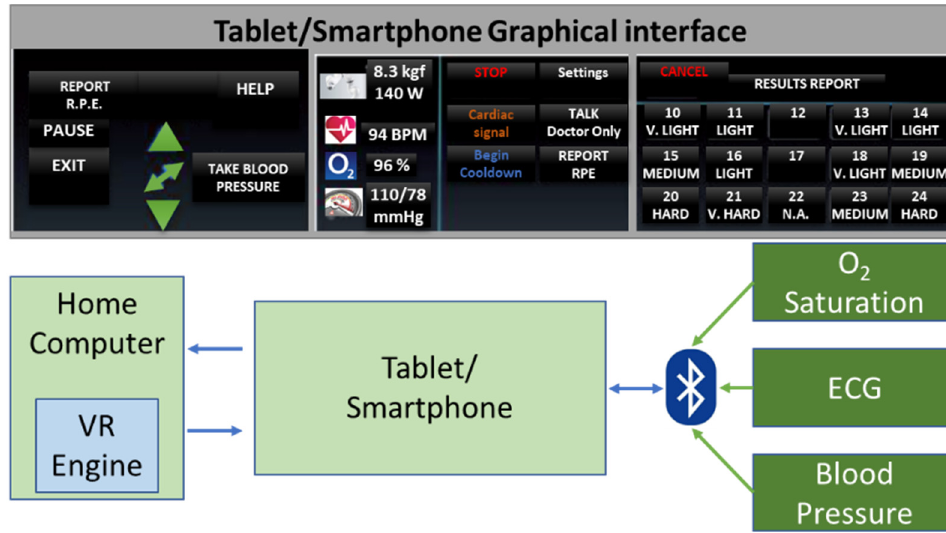
Figure 6. Tablet/smartphone interface and data HUB.